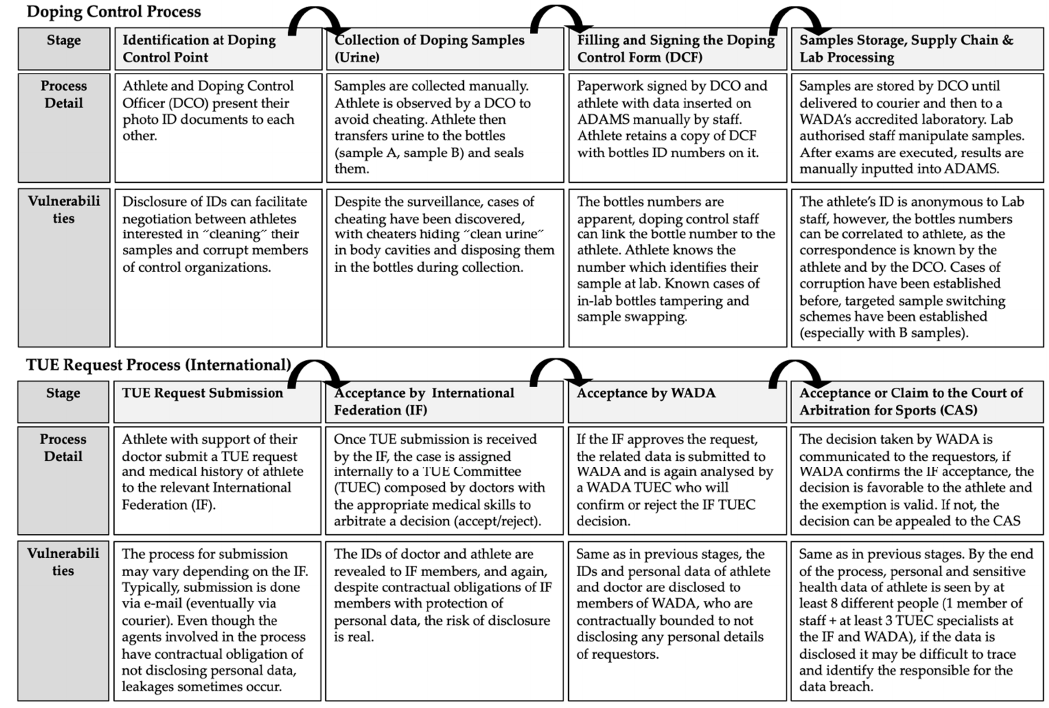
Figure 1. Examples of the current doping control and TUE request processes and their vulnerabili- ties. References: